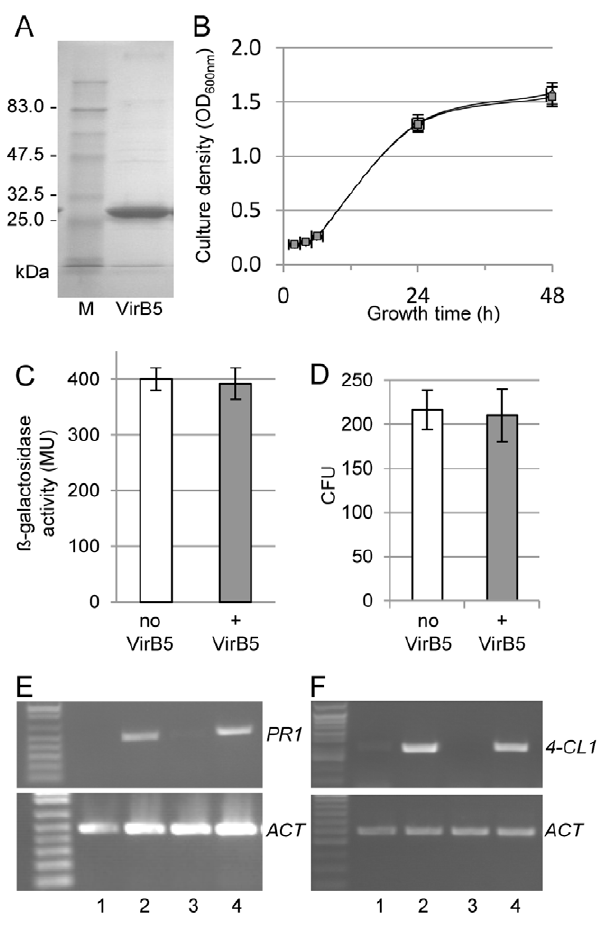
Figure 1. Agrobacterium cell growth, vir gene expression, attachment to host cells, and host defense response in the presence of exogenous VirB5. (A) SDS PAGE analysis of purified VirB5. (B) Growth curve of Agrobacterium . Gray squares, no VirB5; black squares, + VirB5. (C) vir gene induction by acetosyringone. MU, Miller units. (D) Agrobacterium attachment to plant tissues. CFU, colony- forming units. All data represent average values of three independent experiments with indicated standard deviations. Results obtained in VirB5-treated samples were not statistically different from untreated controls ( P -values . 0.2). (E) RT-PCR analysis of induction of PR1 gene expression by treatment with salicylic acid. Lane 1, control; lane 2, + salicylic acid; lane 3, + VirB5; lane 4, + VirB5 + salicylic acid. (E) RT-PCR analysis of induction of 4-CL1 gene expression by treatment with flagellin 22. Lane 1, control; lane 2, + flagellin 22; lane 3, + VirB5; lane 4, + VirB5 + flagellin 22. Constitutively expressed ACTIN (ACT) was used as internal control (lower